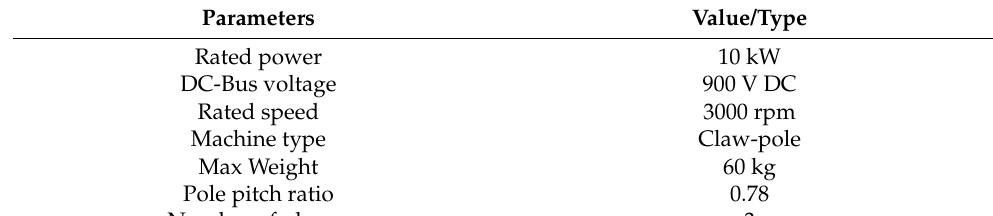
Table 3. Prototype parameters.